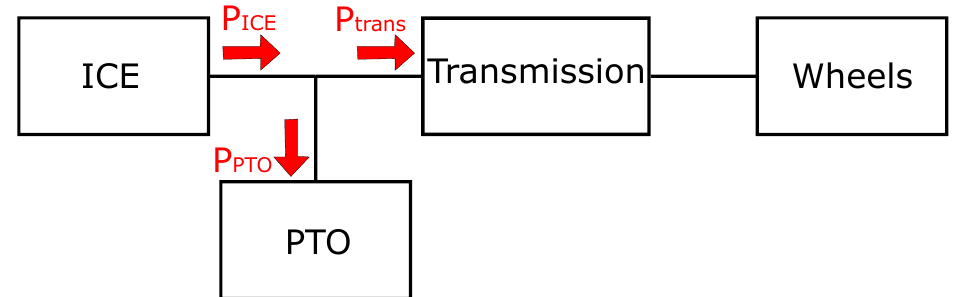
Figure 5. Schematic powertrain power flow